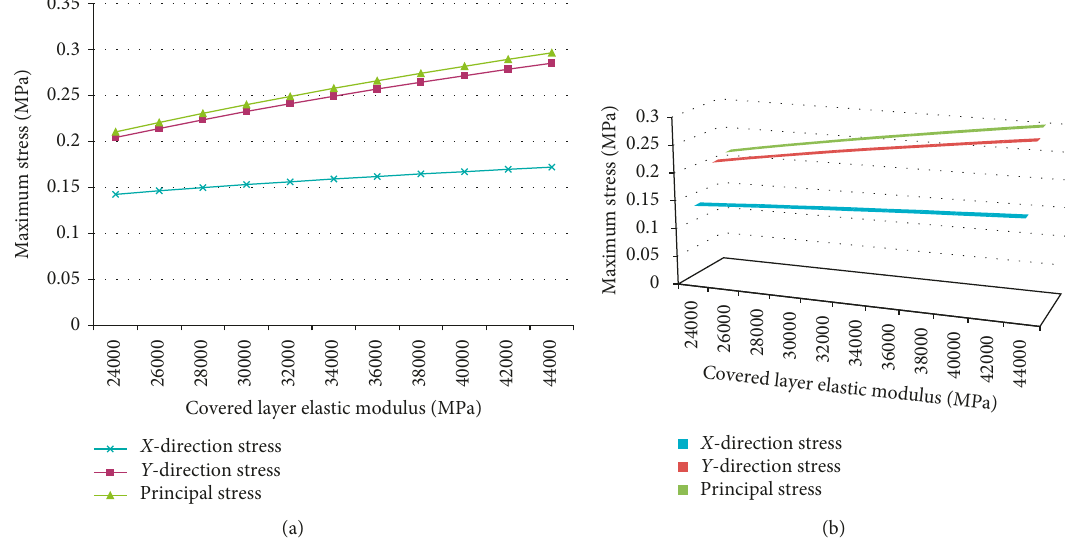
Figure 19: Variation of covered layer stress with covered layer elastic modulus: (a) two-dimensional broken-line graph; (b) three-di- mensional broken-line